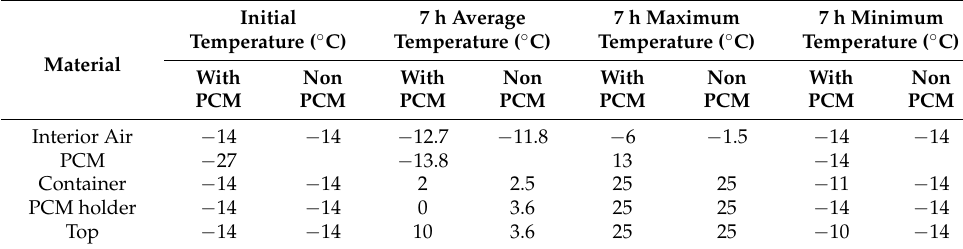
Table 6. Temperature simulation